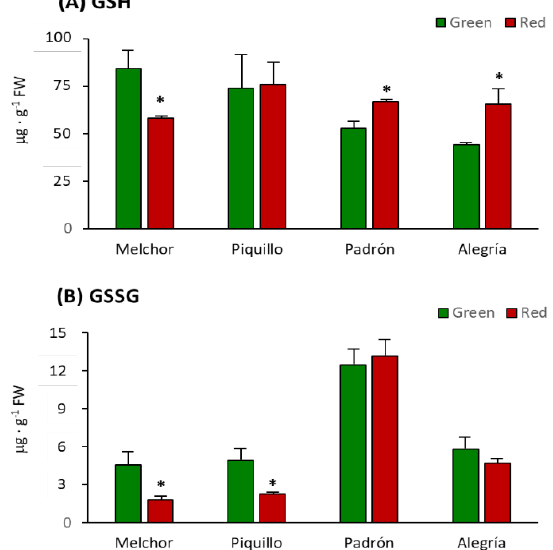
Figure 3. Reduced (GSH) and oxidized (GSSG) glutathione contents in pericarp from fruits of four pepper varieties at two ripening stages. ( A ) GSH. ( B ) GSSG. Data are the means ± SEM of three replicates determined from five fruits of the four varieties and at the two ripening stages. Asterisks indicate significant differences of red fruits with respect to green fruits for each variety ( t -student, p < 0.05). FW, fresh weight. Table 3. Total glutathione (GSH + GSSG) and the ratio GSH/GSSG from fruits of four pepper varieties at two ripening stages.